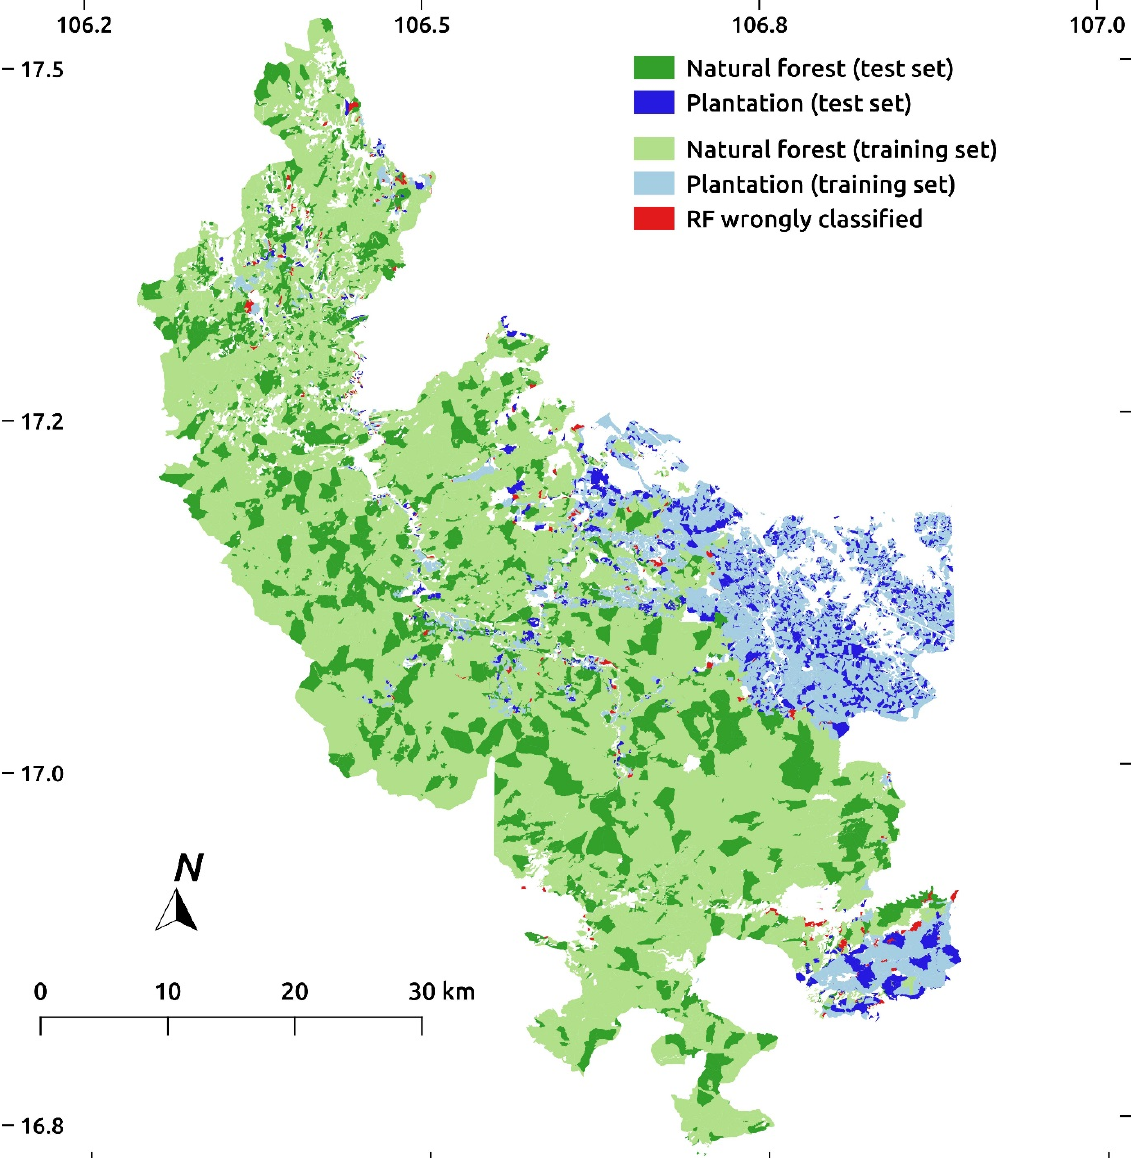
Figure 5. Random Forest (RF) classification using Sentinel-2 images and ancillary data of 5306 acacia plantation and natural forest shapefiles across the study area: these shapefiles comprise the test set, with the remaining 15868 shapefiles used for training. Red shapefiles indicate misclassification.